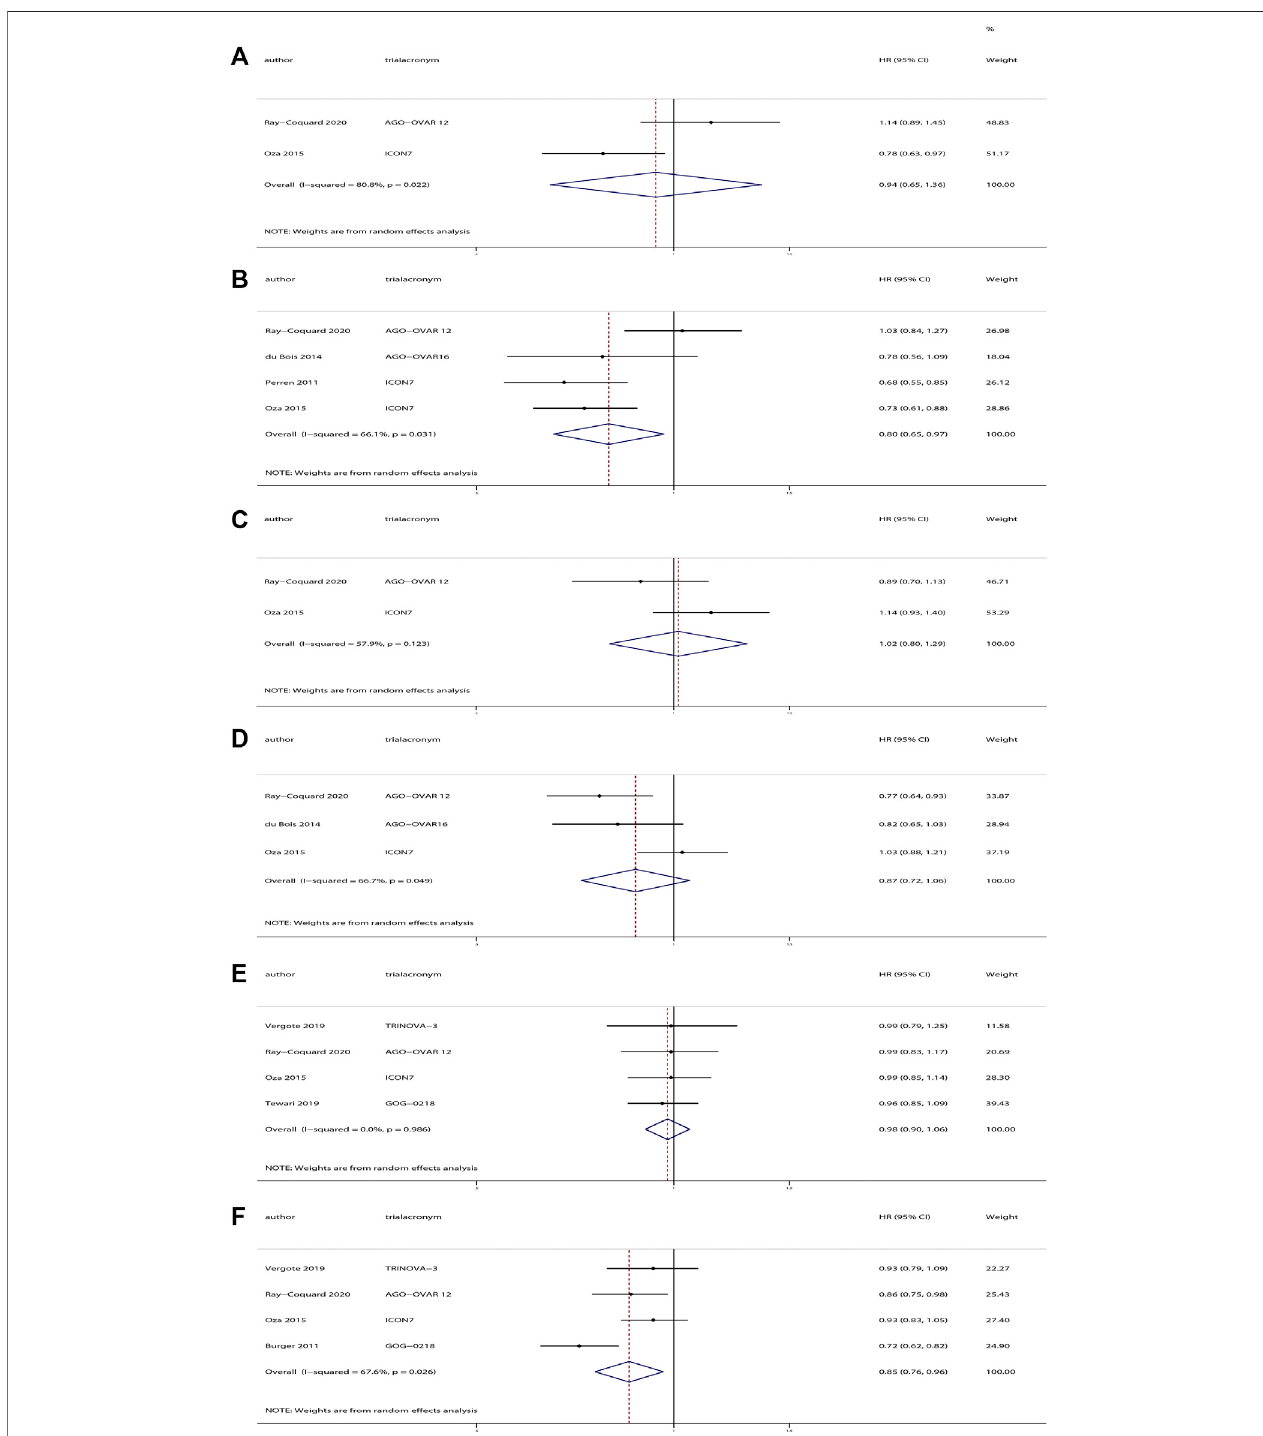
FIGURE 3 | Subgroup analyses of anti-angiogenesis treatment vs placebo in newly diagnosed ovarian cancer. (A) Overall survival (OS) of patients with high-risk tumors. (B) Progression-freesurvival(PFS)ofpatientswithhigh-risktumors. (C) OSofpatientswithnon-high-risktumors. (D) PFSofpatientswithnon-high-risktumors. (E) OS of patients who received anti-angiogenesis treatment in combination with chemotherapy followed by anti-angiogenesis maintenance treatment vs. placebo. (F) PFS of patients who received anti-angiogenesis treatment in combination with chemotherapy followed by anti-angiogenesis maintenance treatment vs. placebo.